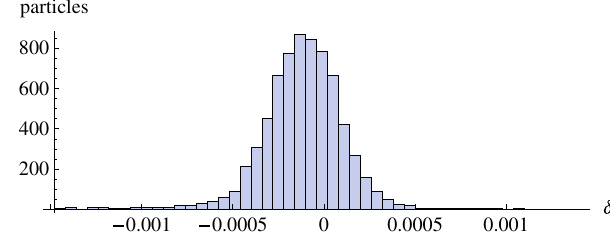
FIG. 14. (Color) The distribution of (cid:4) p caused by EMD2 as simulated by FLUKA . The distribution has h (cid:4) p i (cid:2) (cid:1) 1 : 25 (cid:3) 10 (cid:1) 4 ffiffiffiffiffiffiffiffiffiffiffiffiffiffiffiffiffiffiffiffiffiffiffiffiffiffiffiffiffiffi q hð (cid:4) (cid:1) h (cid:4) iÞ 2 i (cid:2) 2 : 6 (cid:3) 10 (cid:1) 4 . and p p and the recoil caused by EMD, which was simulated with FLUKA (see Fig. 14). The resulting distribution is approximately Gaussian with mean (cid:3) ¼ (cid:1) 1 : 25 (cid:3) 10 (cid:1) 4 and standard deviation (cid:1) ¼ 2 : 9 (cid:3) 10 (cid:1) 4 . We used Eq. (10), with x B replaced by the central EMD2